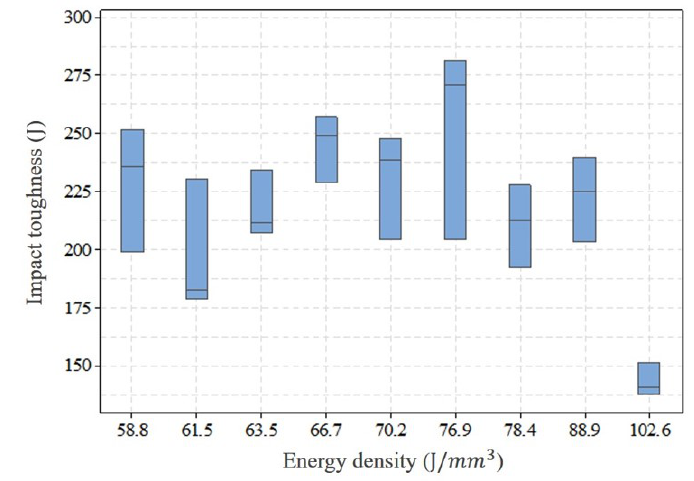
Figure 5. The impact toughness of as-built Charpy specimens printed in the vertical orientation with different parameters